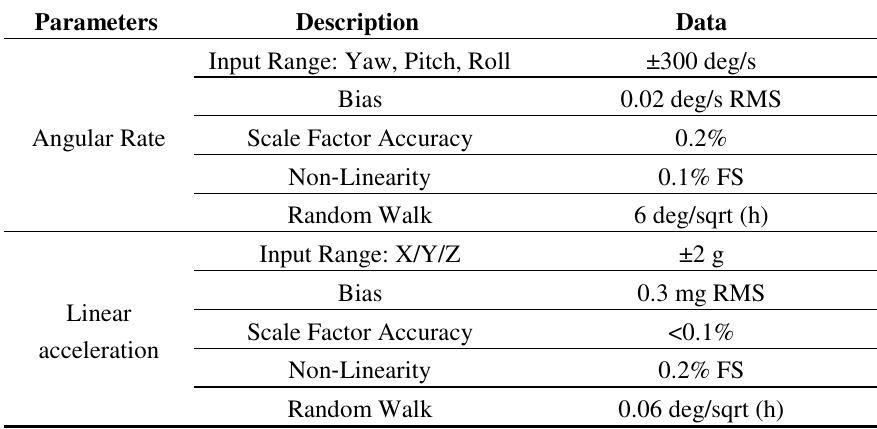
Table 1. The performance parameters for the IMU used in this